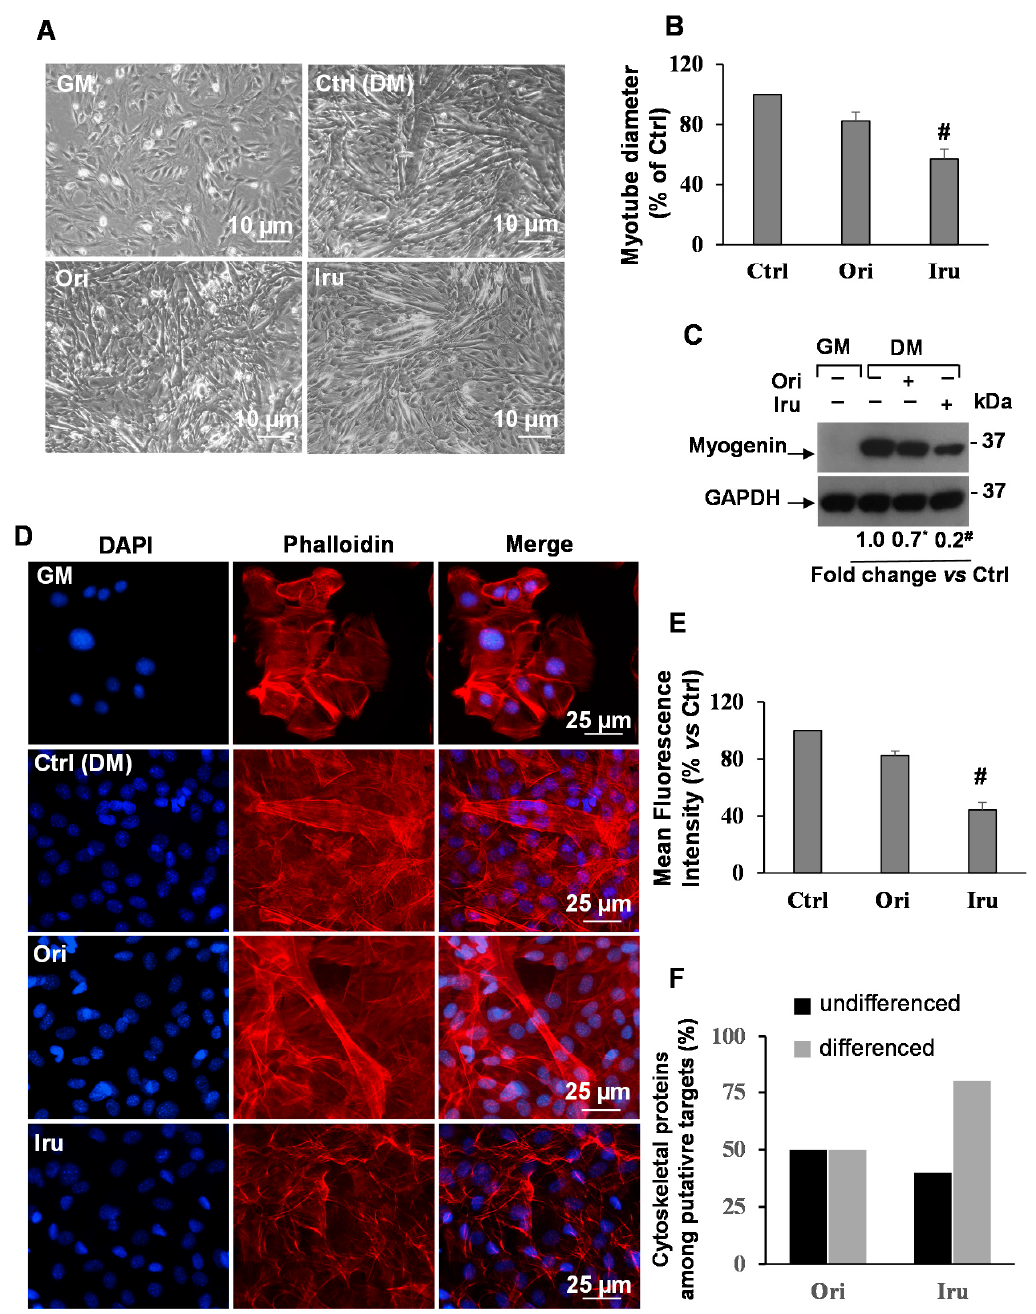
Figure 2. Effect of Ori and Iru exposure on myotube formation and actin cytoskeleton organization in C2C12 cells. ( A ) Phase-contrast micrographs of C2C12 cells cultured in GM, DM or exposed to 10 µM of Ori or Iru. All the treatments were performed for 24 h in presence of 0.1% DMSO, used as vehicle for Ori and Iru. Scale bar = 10 µm. ( B ) Quantitative measurements of mean diameter of myotubes. Histograms represent mean % ± SD ( n = 6), with respect to the Ctrl cells, set as 100%. # indicates values statistically different from control (# p < 0.001). ( C ) Western blotting showing Myogenin protein expression levels. GAPDH was used as loading control for cell lysates. Fold change in Myogenin levels was calculated by first normalizing to GAPDH levels in individual samples and then relative to un-treated control (cells cultured DMEM with 0.1% DMSO, vehicle) set as 1. # and * indicate values significantly different from Ctrl (# p < 0.001; * p < 0.05). Statistical analysis of the results obtained in triplicate experiments are reported in the supplementary Figure S1. ( D ) Representative fluorescence